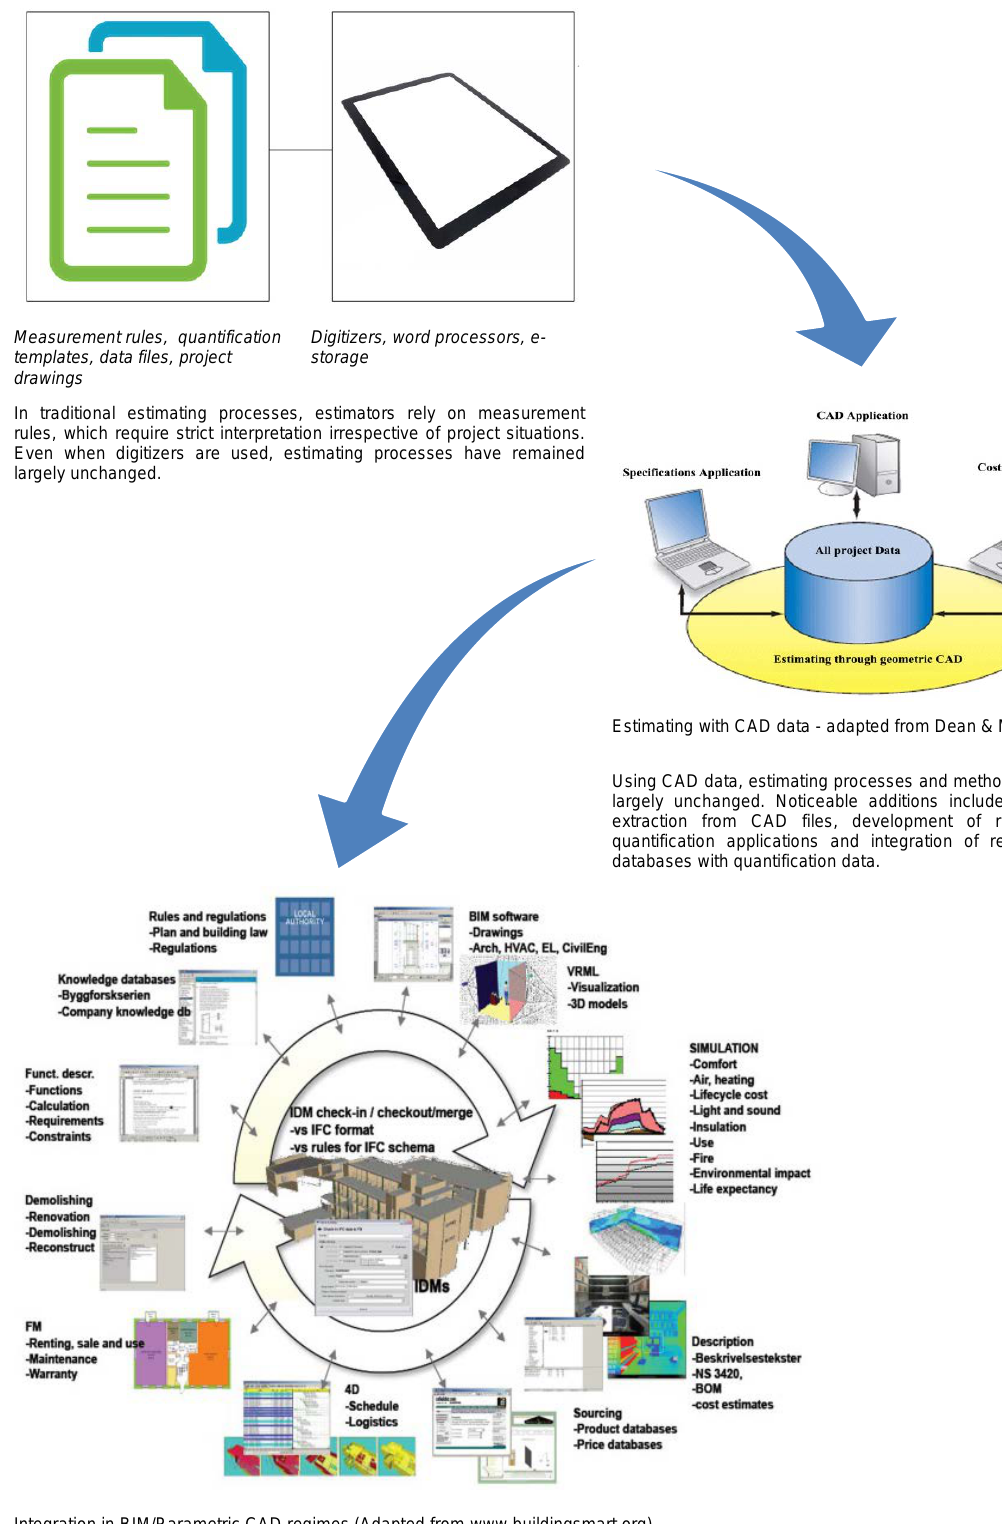
Figure 1: A taxonomy of estimating systems in different design data